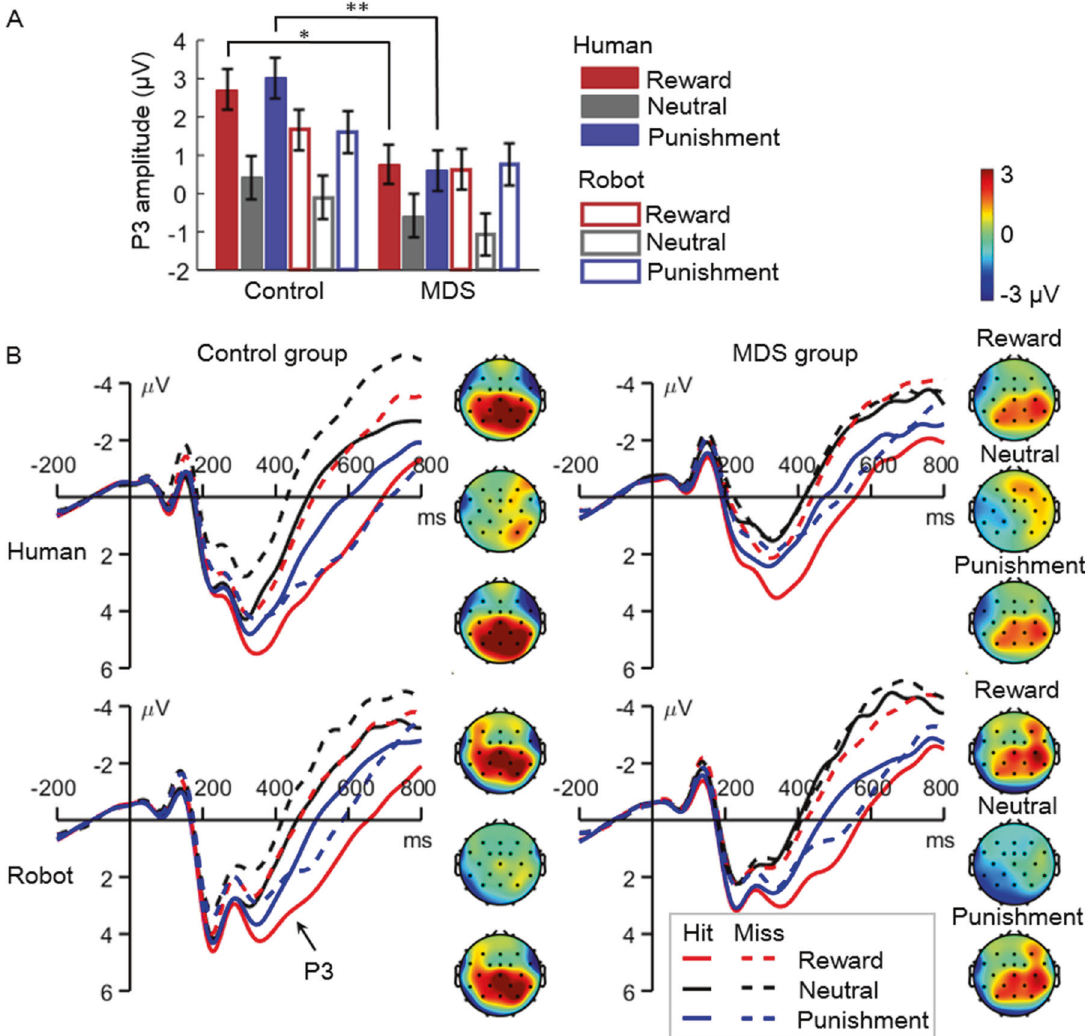
Fig. 4 The results of feedback-evoked P3. A Amplitudes of the P3 in different conditions. * P < 0.05, ** P < 0.01. B The P3 waveforms and topographies. The P3 waveforms were averaged across electrodes of Pz, P3, P4, CP1, and CP2. The P3 topographies were averaged across a time window of 300 – 600 ms post